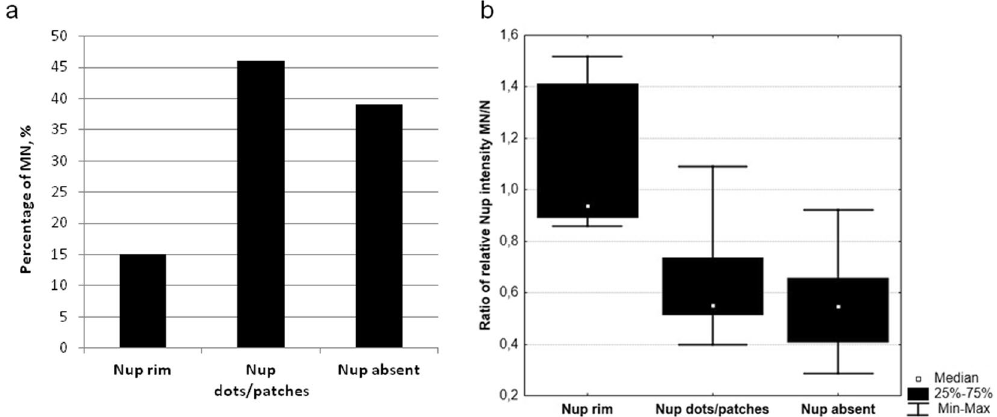
Figure 3. Quantitative analysis of nuclear pore complex proteins in micronuclei. ( a ) Frequency of micronuclei (MN) with various distribution of nuclear pore complex proteins (Nup) assessed by morphological criteria. ( b ) Ratios of Nup relative fluorescence of micronuclei (MN) to main nuclei (N) according to three classes of Nup distribution (rim, dots/patches, absent) in gonocytes of hybrid